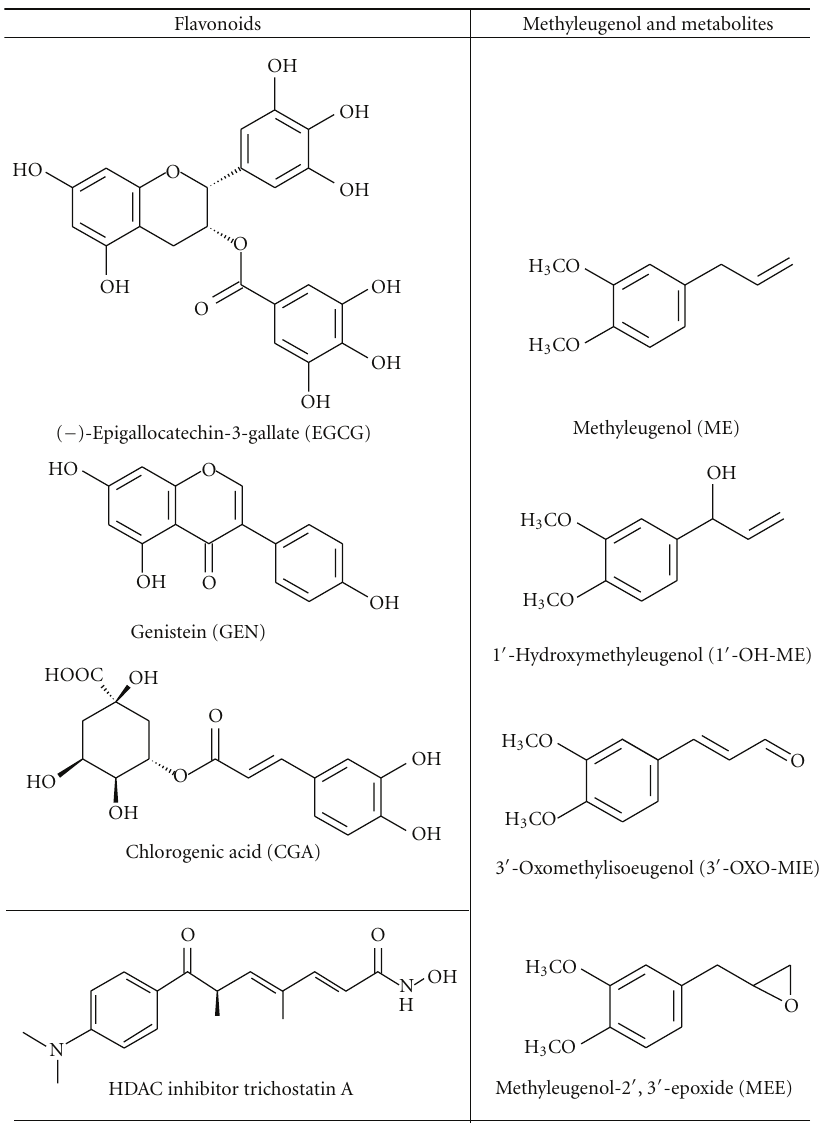
lysed by the addition of 50 𝜇 L Lysis/Developer Mixture (kit constituent) and the plate was shaken for 2 minutes.